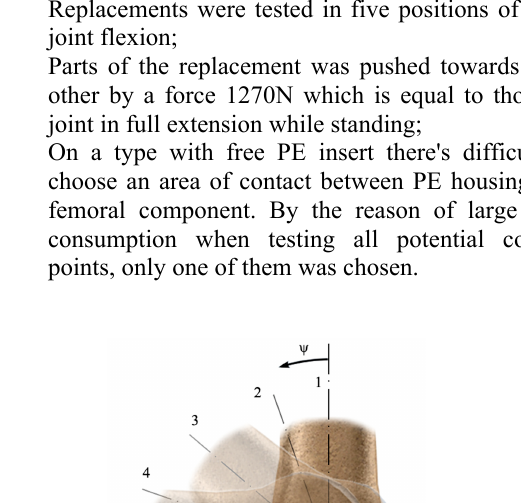
Fig.4. Snapshots of